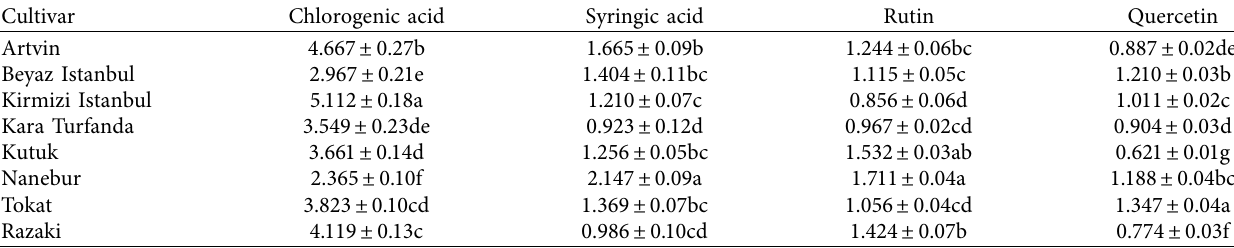
Table 2: Major phenolic compounds in berries of grape cultivars (mg/l).